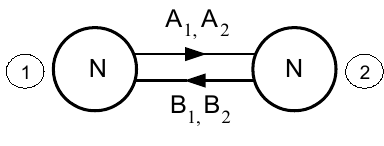
Figure 8 . The KW